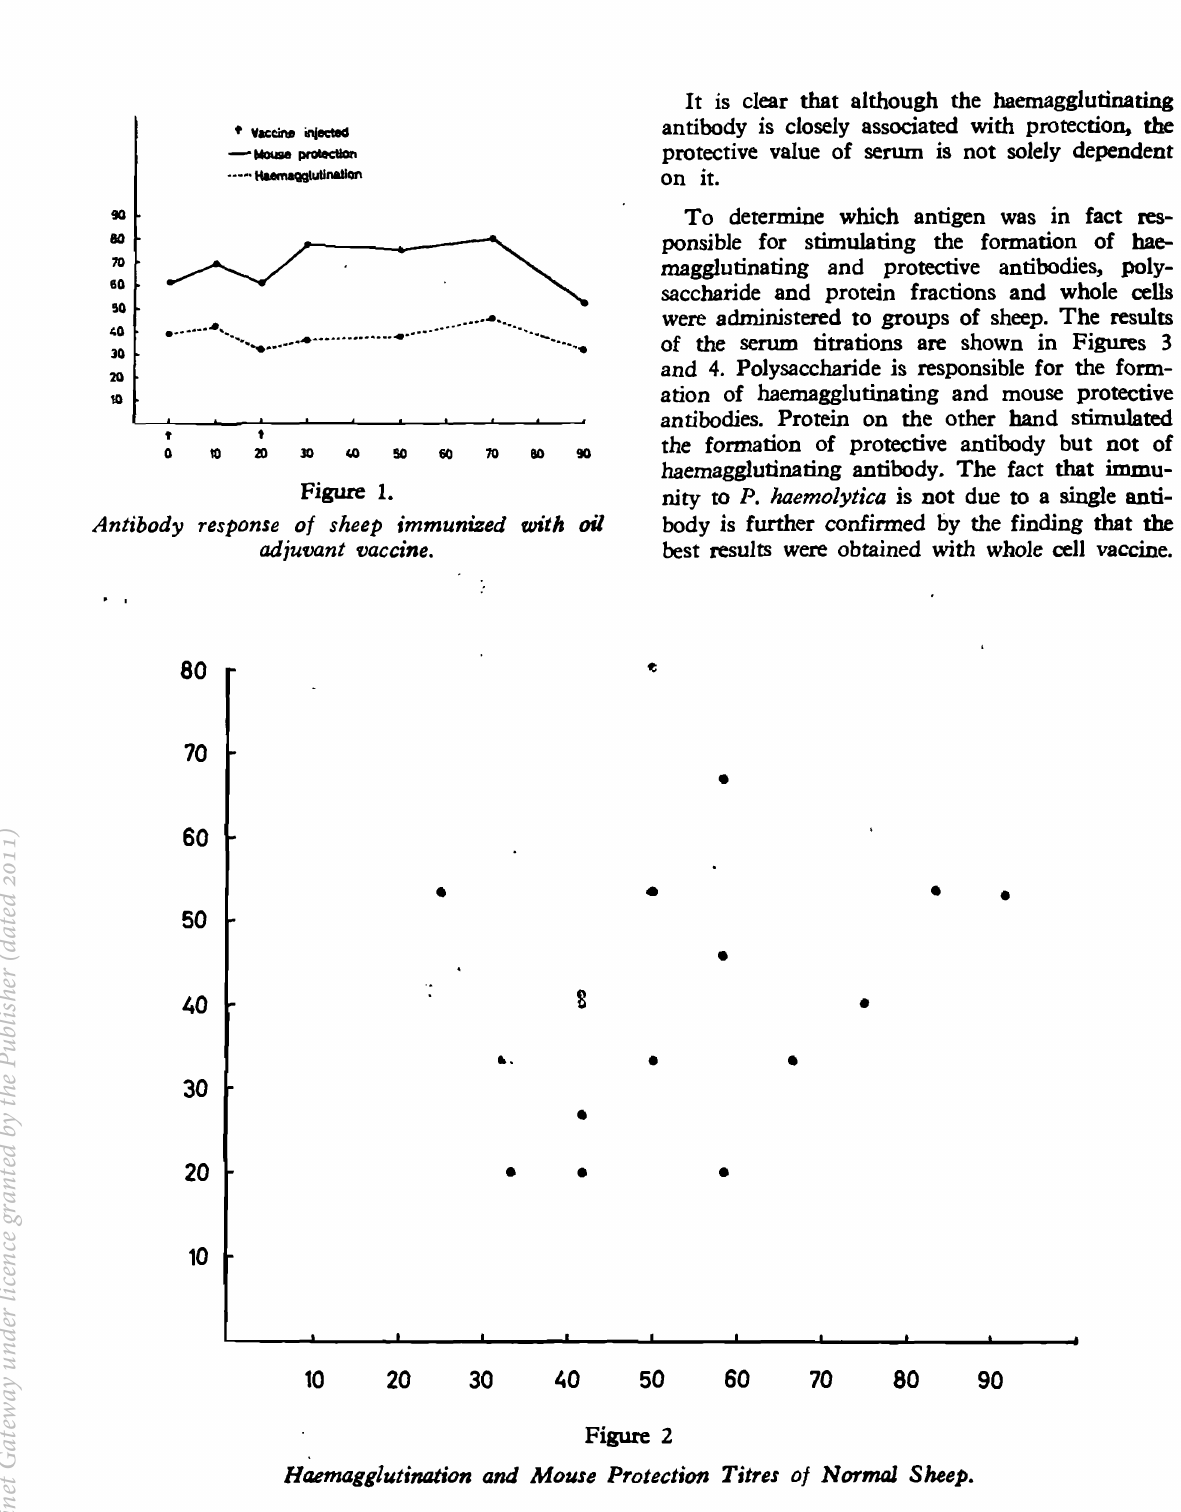
Haemagglutination and Mouse Protection Titres of Normal